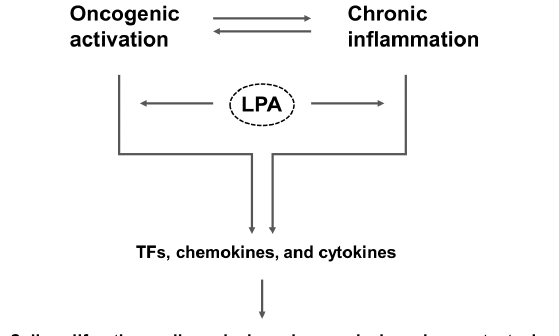
Figure 1. Overall scheme that connects LPA to inflammation and cancer. LPA-mediated signaling activates both oncogenic and inflammatory pathways that promote tumorigenesis. TFs, transcription factors.